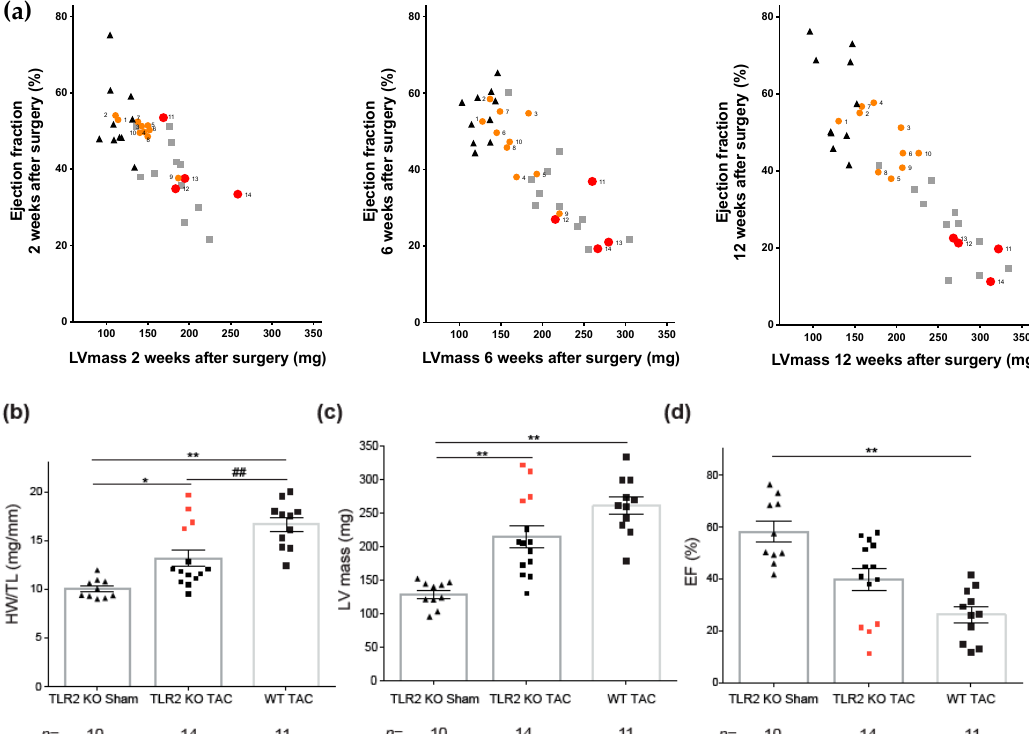
Figure 5. Mice with highest levels of TLR4 had the worst cardiac function. ( a ) Correlations between left ventricular mass (LV mass, mg) and ejection fraction (EF; %) over time at 2 weeks (left panel), 6 weeks (middle panel), and 12 weeks (right panel) after surgery. Black triangles depict mice of the TLR2 KO sham group, orange and red circles depict mice from the TLR2 KO TAC group, and gray squares represent mice from the WT TAC group. Red circles indicate mice with highest TLR4 mRNA levels. Numbers indicate the individual mice in the WT-TAC group ( b ) Heart weight to tibia length ratio (HW/TL, mg/mm) of TLR2 KO sham, TLR2 KO TAC, and WT TAC mice 12 weeks after surgery. ( c ) Left ventricular mass (LV mass, mg) measured by echocardiography after 12 weeks of TAC or sham surgery. ( d ) EF (%) measured by echocardiography after 12 weeks of TAC or sham surgery. n indicates the number of mice per group. A one-way ANOVA followed by Tukey’s test was used: * p < 0.05, ** p < 0.01, and ## p < 0.01.